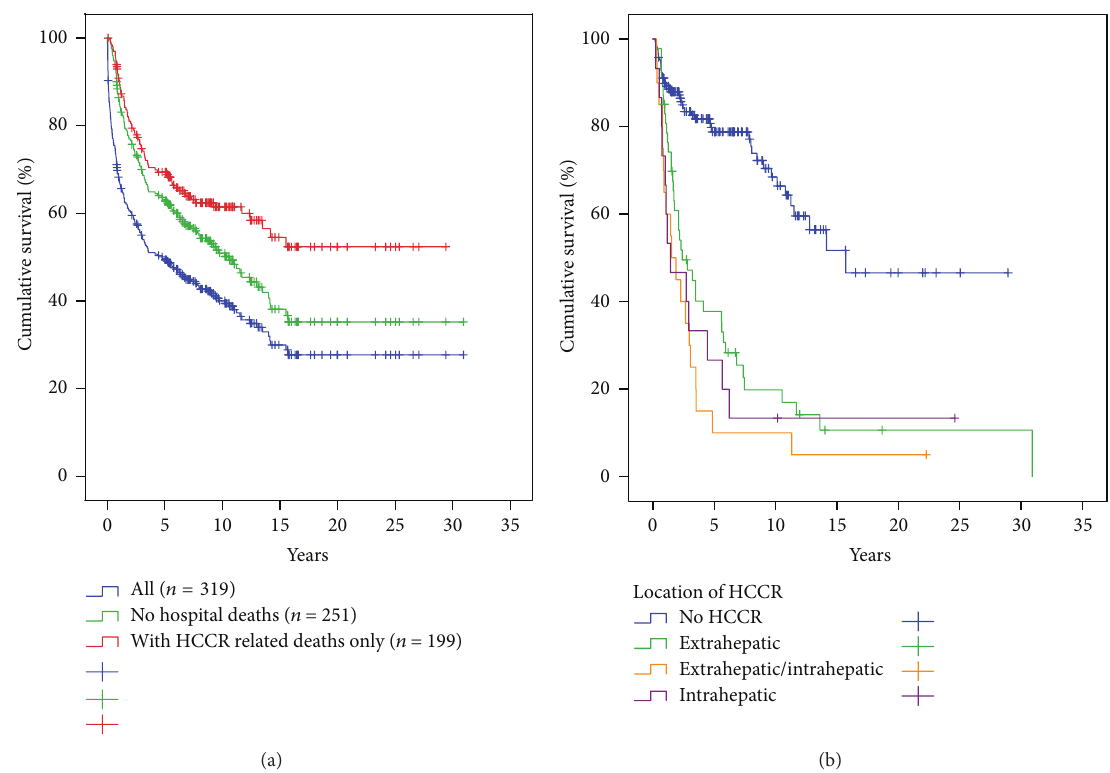
Figure 3: Survival with respect to hospital mortality and HCC recurrence. (a) Cumulative survival of all patients ( 𝑛 = 319 , blue line ), without hospital mortality ( 𝑛 = 251 , green line ) and with HCC recurrence related deaths only ( 𝑛 = 199 , red line ). (b) HCC recurrence-free survival (blue line, Cox regression analysis with HCC recurrence as time-dependent covariate) and with respect to extrahepatic (green line), intrahepatic (red line), or combined extrahepatic/intrahepatic HCC recurrences (orange line). HCC recurrence was highly significant hazard of survival ( 𝑝 < 0.001 , exp (𝐵) = 10.156 ), but it made no difference to survival whether HCC recurrences were at intrahepatic, at extrahepatic, or at combined intrahepatic/extrahepatic locations ( 𝜎 2 𝑝 > 0.05